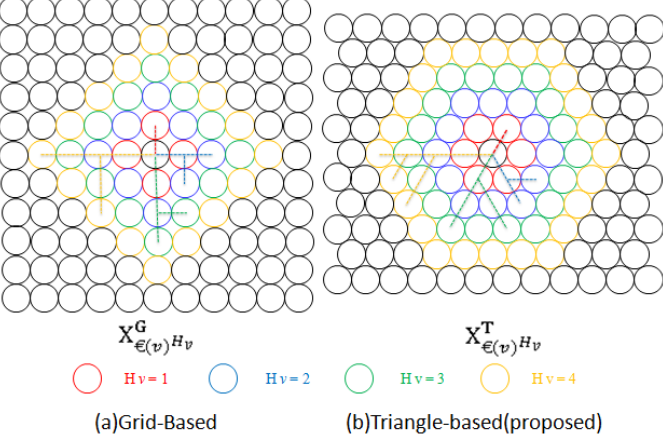
Figure 2. New sensor deployment based on higher density of hop distance